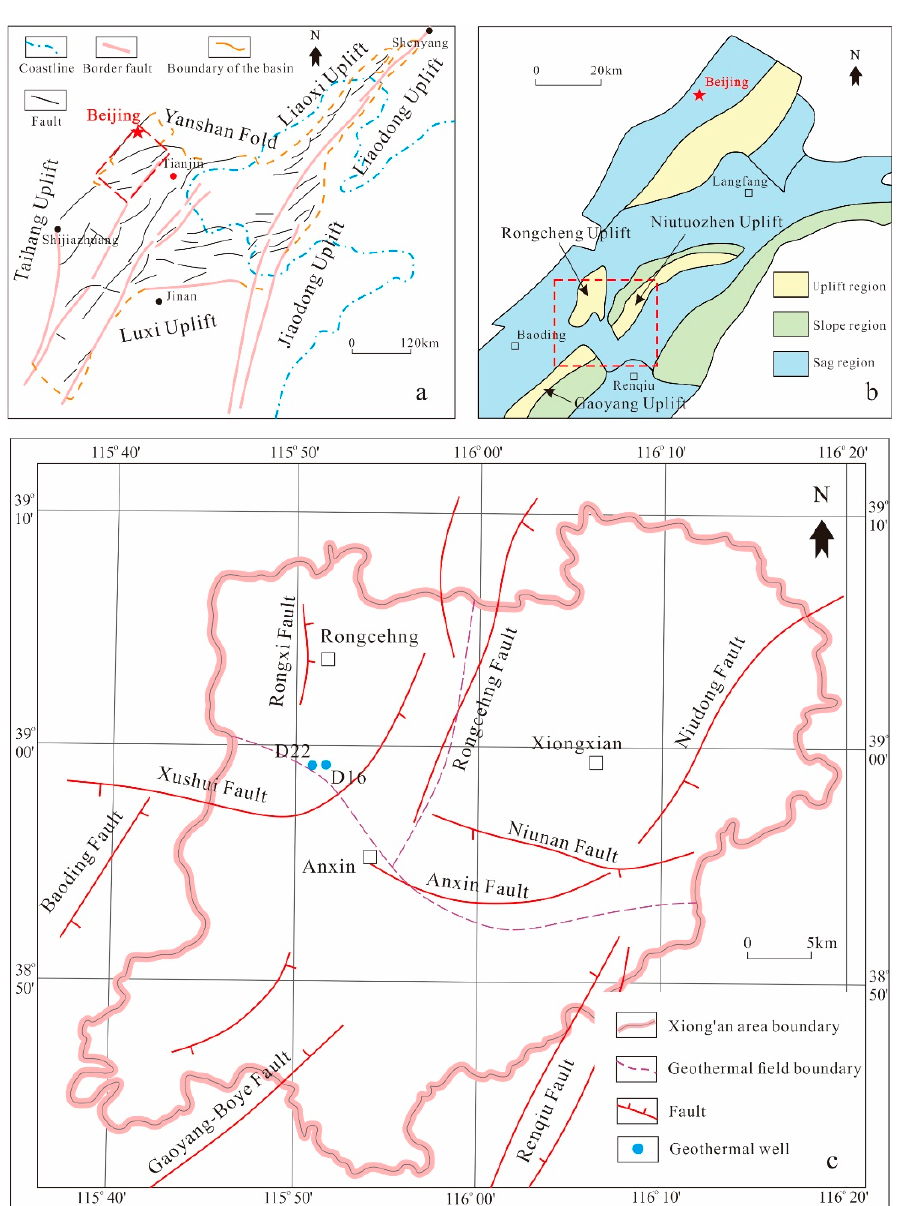
Figure 1. ( a ) Basic structural map of the Bohai Bay Basin; ( b ) Basic structural map of the Jizhong Depression [28]; and ( c ) Map showing the distributions of the major faults, geothermal fields, and boreholes in the Xiong’an New Area.